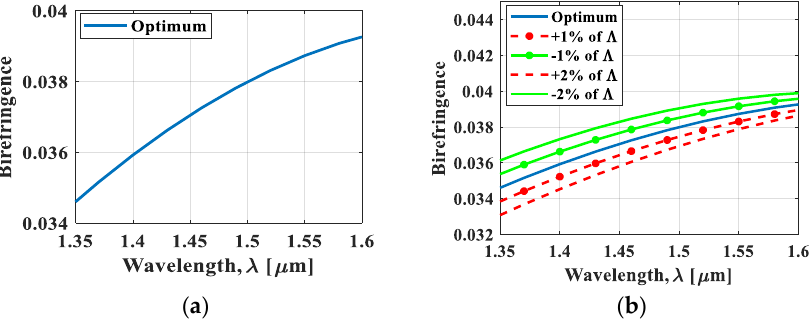
Figure 2. Birefringence as a function of wavelength for ( a ) optimal design parameters: pitch ( Λ ) = 0.76, d 1 / Λ = 0.95, and d 2 / Λ = 0.8; and ( b ) by varying the value of pitch ( Λ ) = 0.76 from ±1% to ±2%.